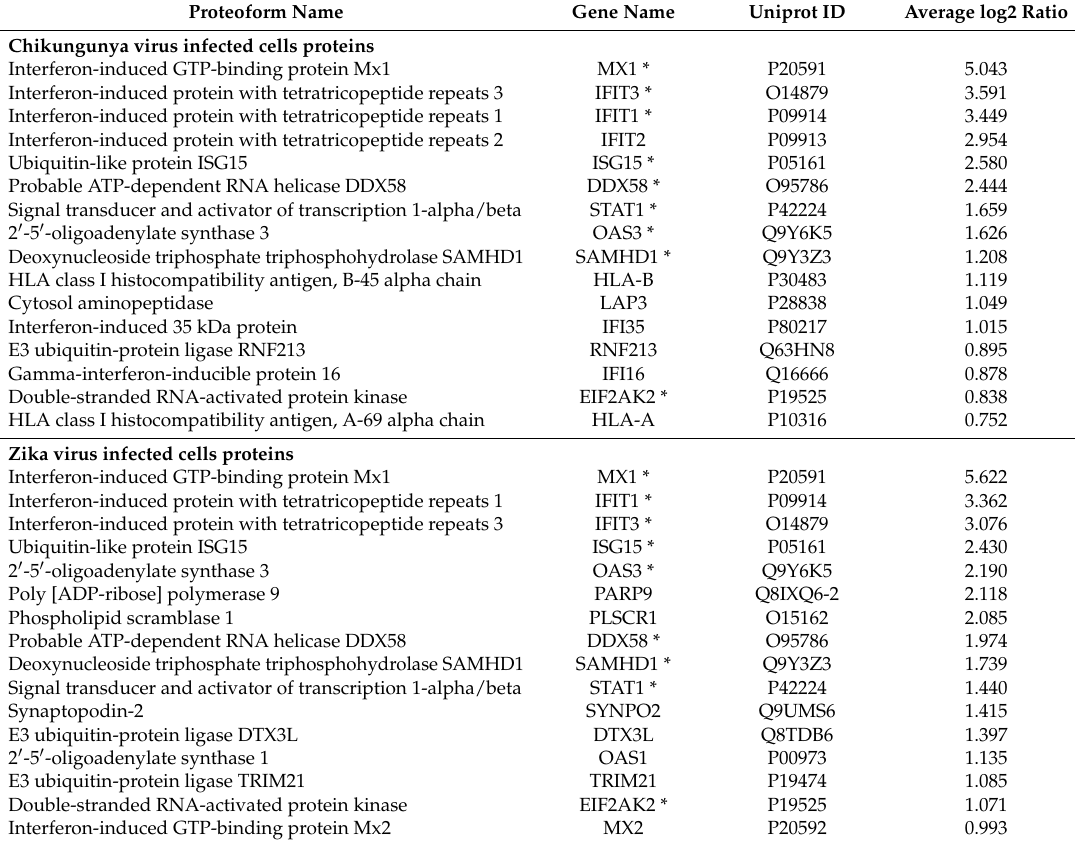
Table 1. Proteins with significantly up-regulated expression in CHIKV- and ZIKV-infected cells. Proteoform Name Gene Name Uniprot